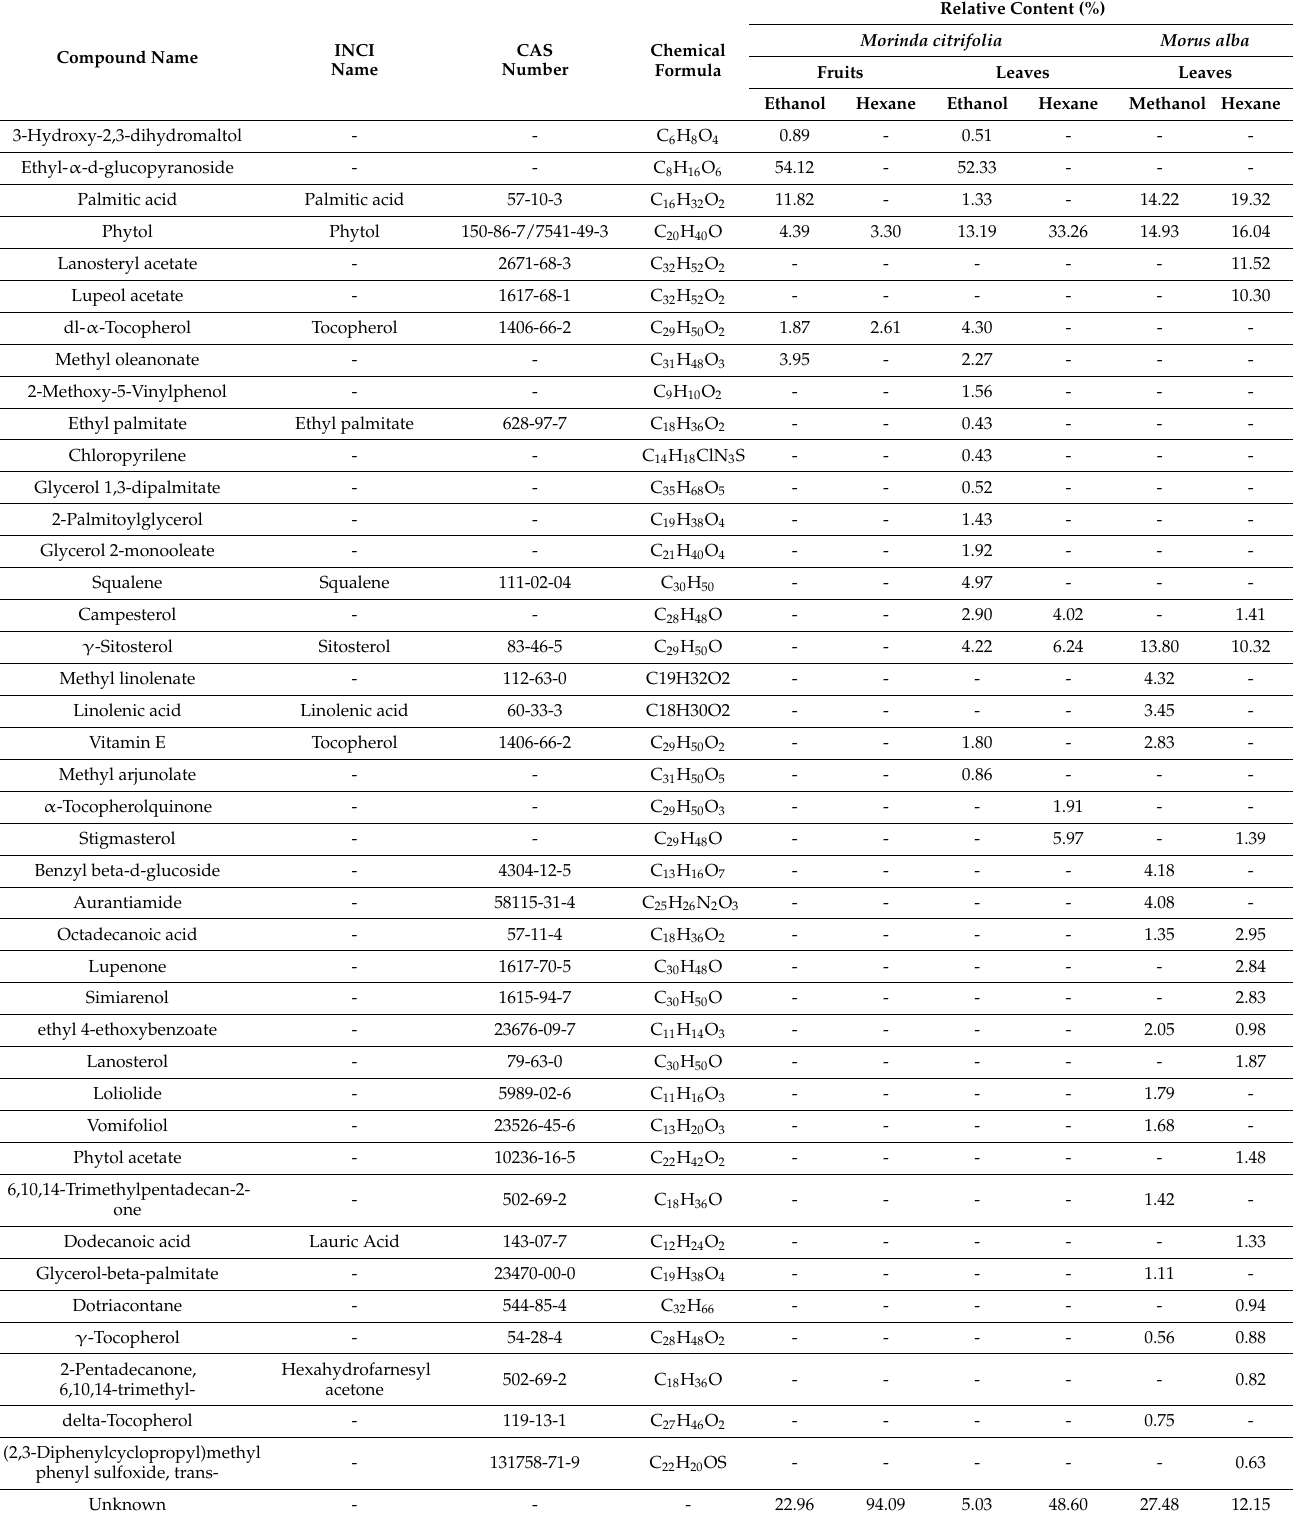
Table 1. A summary of chemical constituents sorted by relative content percentages, analyzed by GC-MS in hexane and ethanol Morus alba (Ma) and Morinda citrifolia (Mc) extracts. For Mc, whole fruits (raw with seeds) were